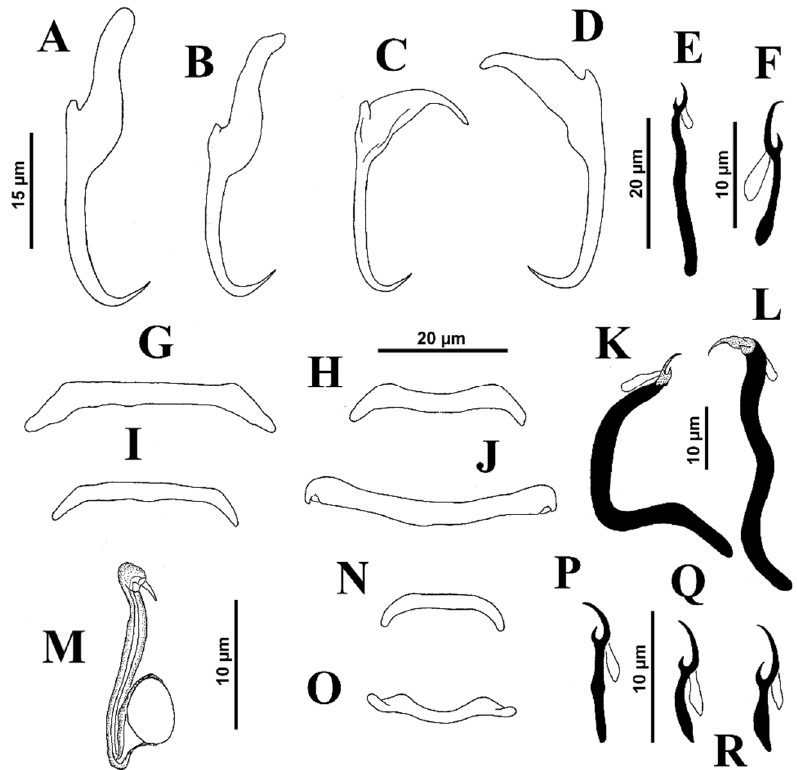
Figure 3. Sclerotized structures of Neohaliotrema variabilis n. sp. from the beaugregory Stegastes partitus . ( A , B ) Ventral anchors ( C , D ) Dorsal anchors ( E ) Hook pair 1 ( F ) Hook pairs 4 ( G – I ) Ventral bars ( J ) Dorsal bar. ( K , L ) Hook pairs 3. ( M ) Copulatory complex. ( N , O ) Ventral bars ( P ) Hook pairs 2 ( Q , R ) Hook pairs 7.